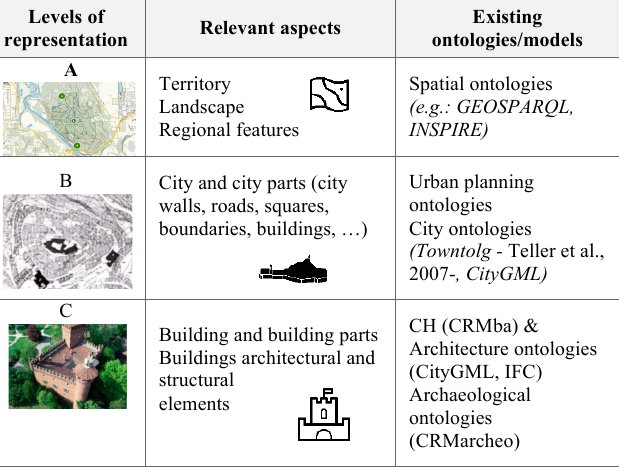
Table 1. Level s of detail in the domain of CH.